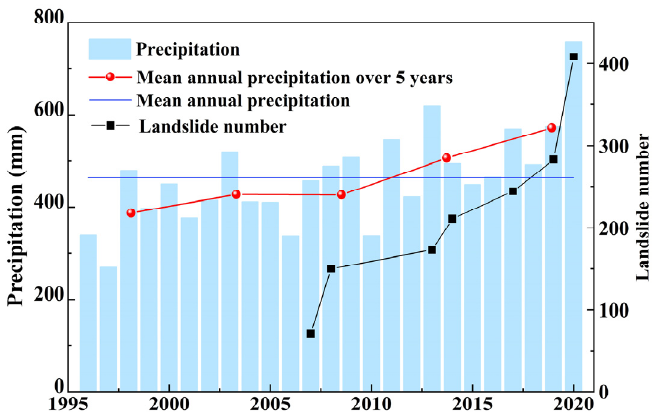
Figure 15. Precipitation and landslide number.